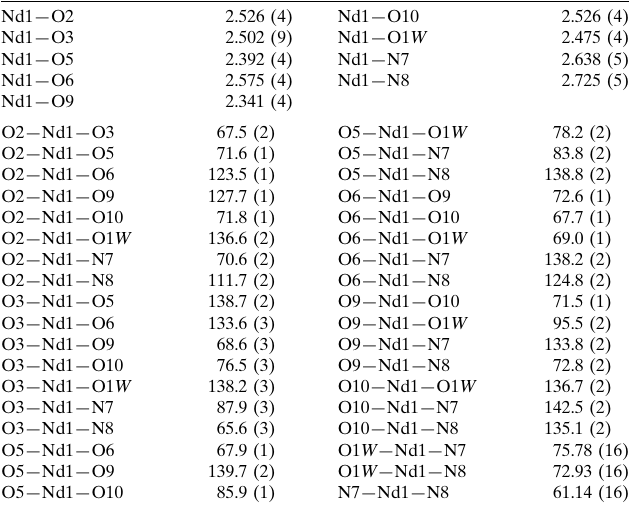
Selected geometric parameters (A˚ , (cid:2)